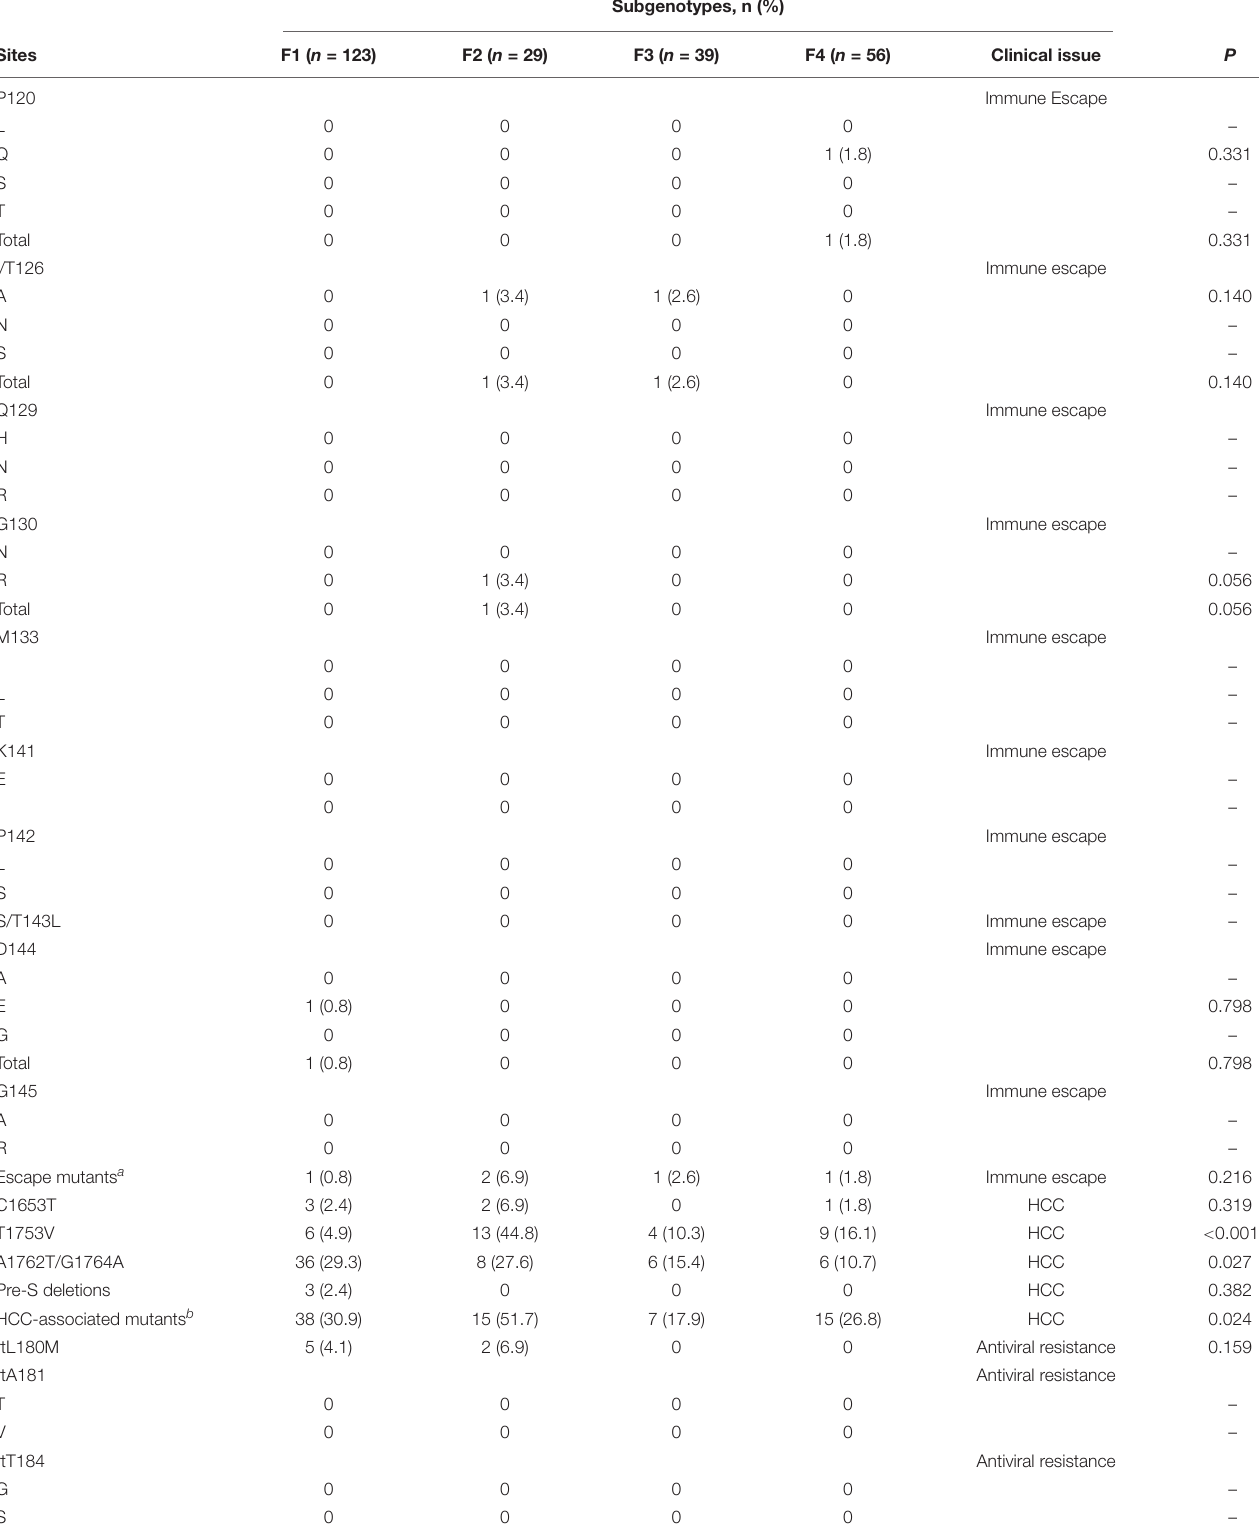
TABLE 6 | Clinically relevant mutations in HBV/F